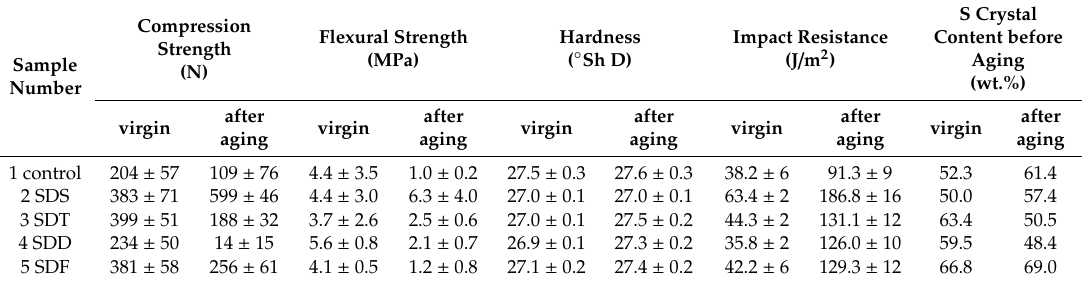
S Crystal Impact Resistance Content before (J / m 2 ) Aging (wt.%)